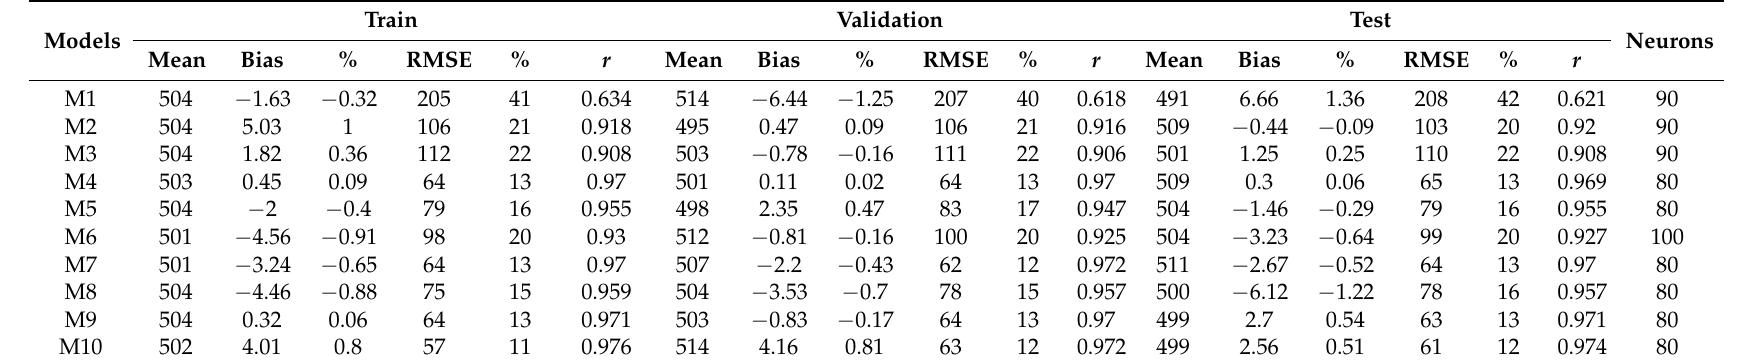
Table A3. As in Table A1, but for Hojava tower station.